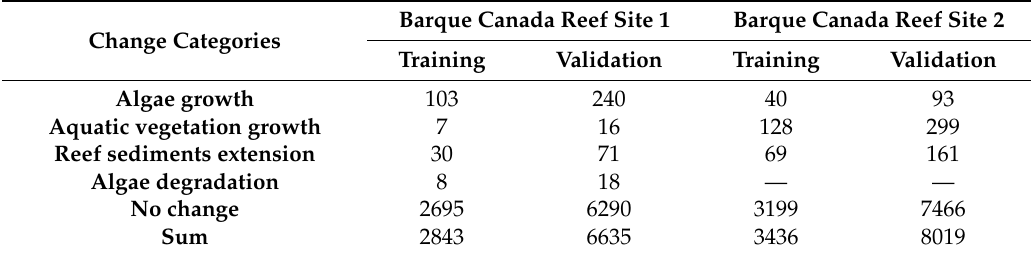
Table A5. The object sample numbers of all change categories in Barque Canada Reef. Change Categories